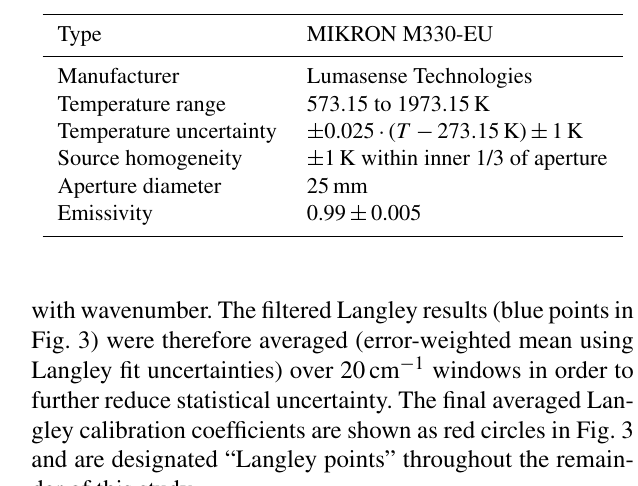
Table 2. Specifications of the blackbody calibration